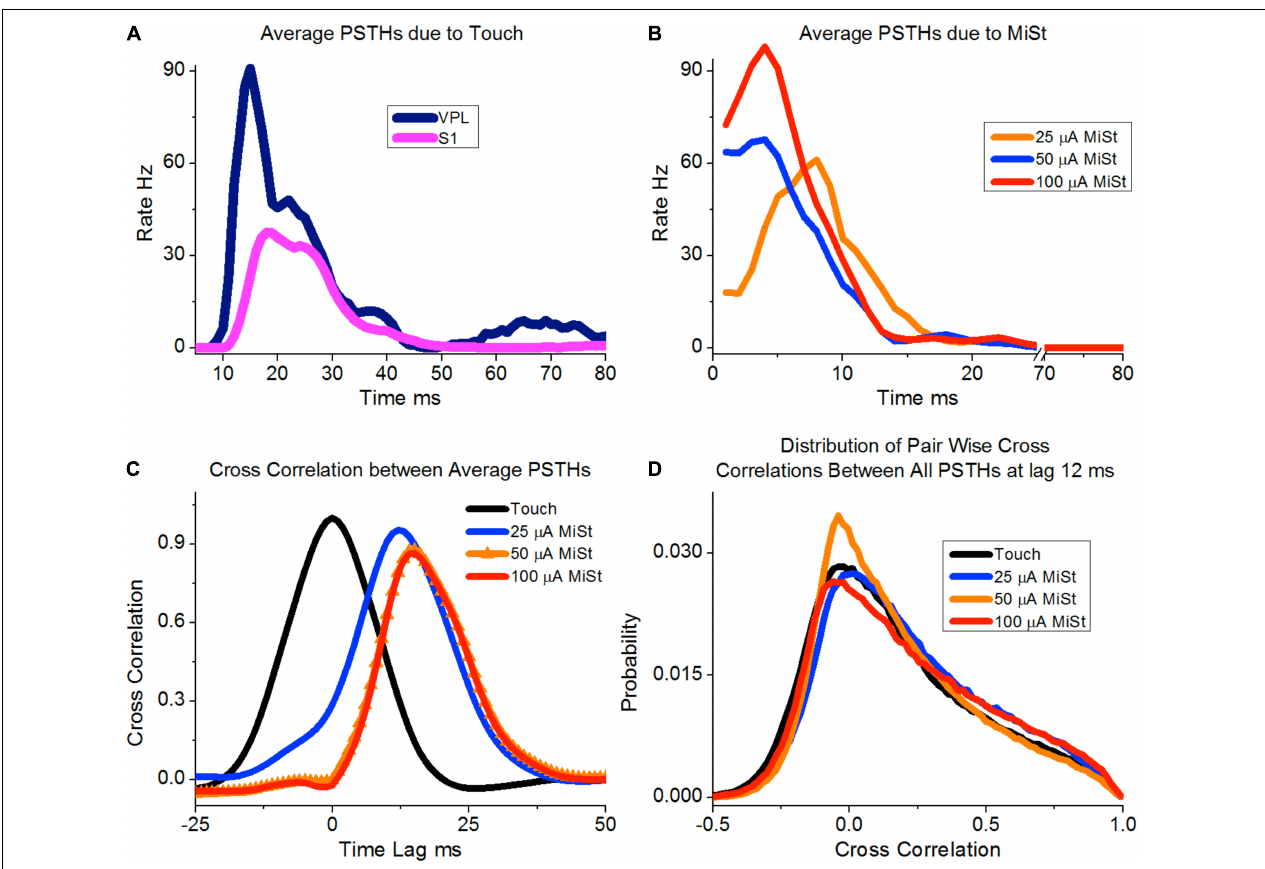
FIGURE 3 | This cartoon summarizes results showing agreement between the somatotopic relationship from VPL to S1 under natural touch (C) and VPL-MiSt (D) . (A) Diagram of the macaque’s hand labeled and color-coded with positions that were stimulated via our tactor. These same colors are used to describe the stimulus fields on the S1 electrodes (B) and VPL electrodes (C) . (D) Are the VPL electrode pairs used for our bipolar microstimulation. Note that two of the four VPL electrodes recorded strong SF to touch (1, 2) while the other two were weak (3, 4) and possibly on the boundary of the VPL. The terms D2dors and D5dors are the digit number on the dorsal surface. Due to this arrangement, the cortical stimulus fields to VPL stimulation are governed by the strong VPL channels. See Choi et al. (2016) for a similar relationship in the